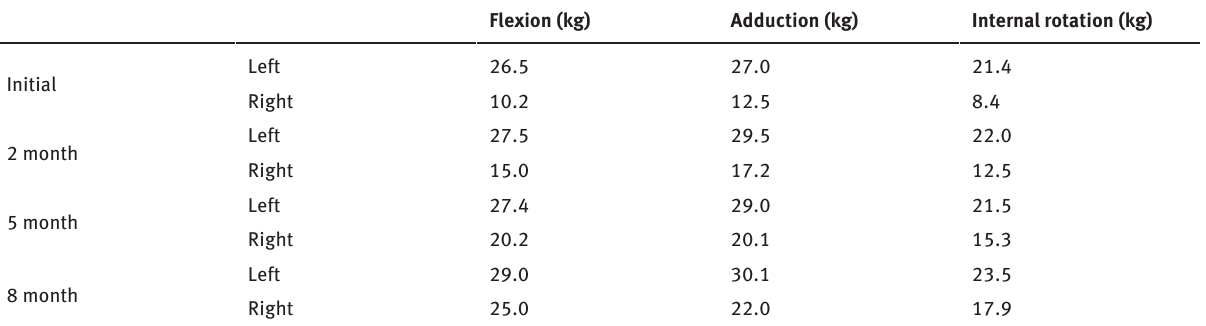
Table 2. Results of strength tests in Patient 1